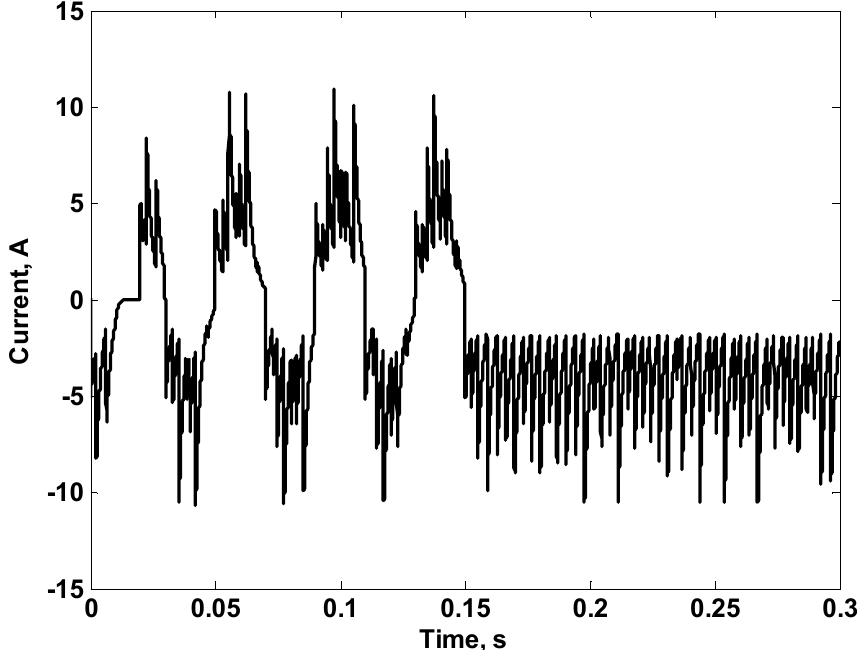
Figure 35. Obtained Current when the Reference Signal is Adjusted at 110 V, 25 Hz with a transfer to a DC signal of − 200 V at 0.15 s.